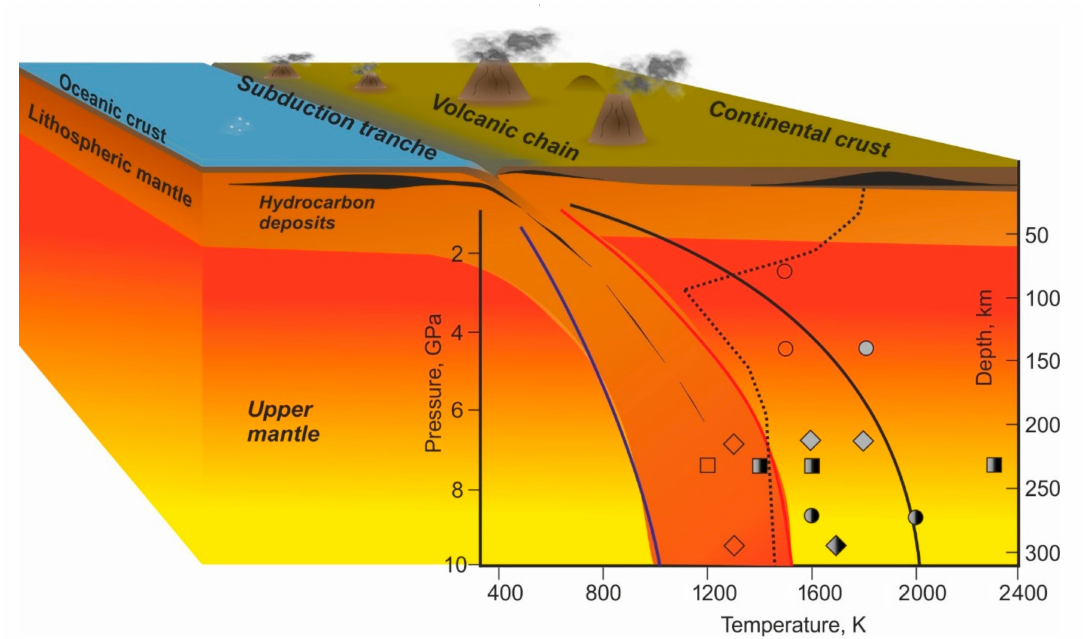
Figure 3. Chemical reactions between hydrocarbons and oxides and silicates. Circles —pyroxene-like glass (Mg 0.91 Fe 0.09 )(Si 0.91 Al 0.09 )O 3 + para ffi n oil, diamonds —ferropericlase (Mg 0.8 Fe 0.2 )O + crude oil, squares —iron oxide (II) Fe 0.94 O + para ffi n oil, open symbols —no reaction, shaded grey —iron hydride present in the run product, shaded black —iron hydride and iron carbide are present in the run product. Pressure-temperatures profiles of the coldest (blue solid line) and the hottest (red solid line) subduction slabs are taken from Karato [9]. Earth’s geotherm (black solid line) is modified after Pollack and Chapman [26] and the black dashed line is the melting curve of γ -FeH x